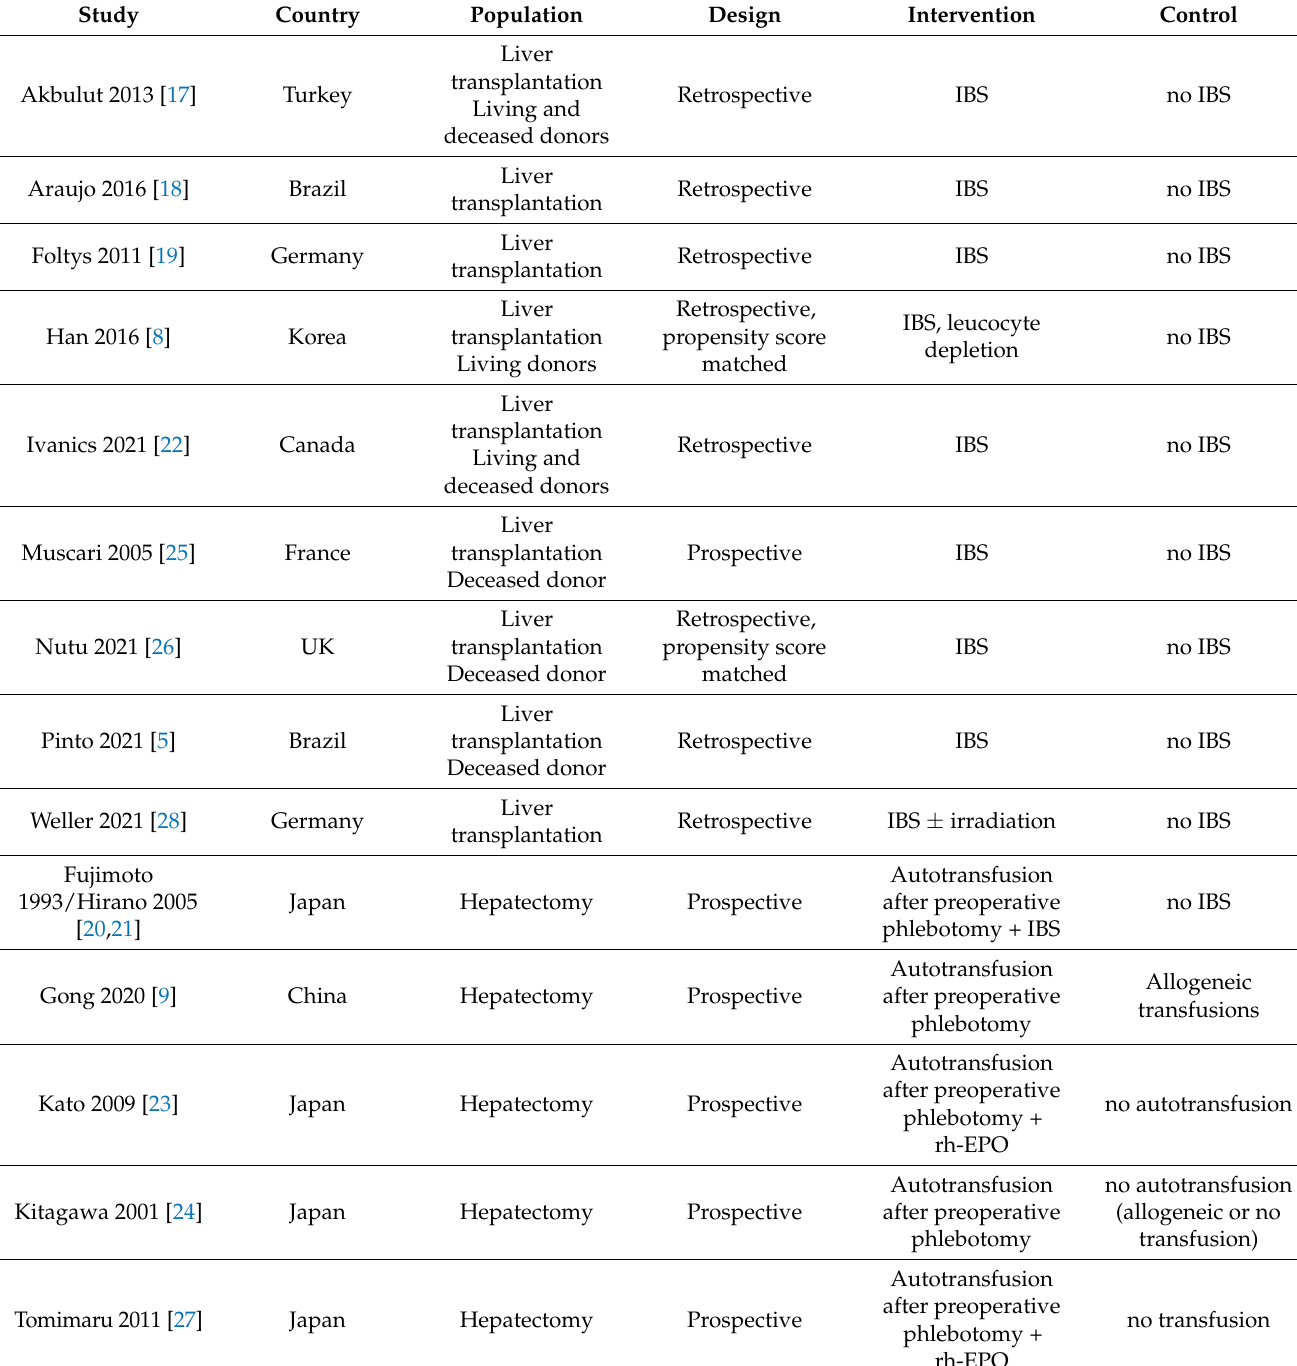
Table 1. Overview of included